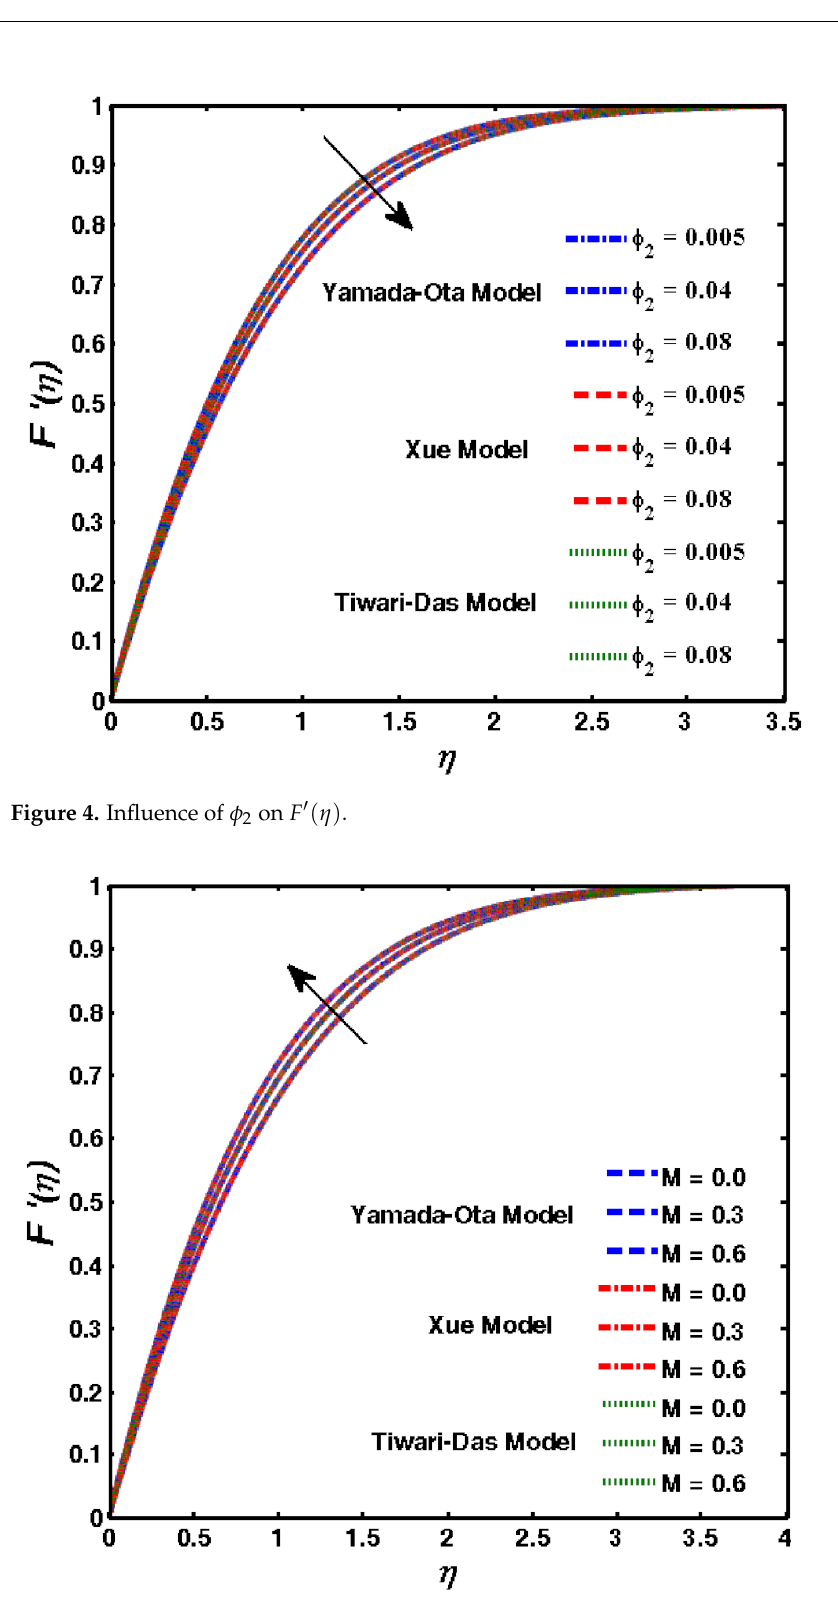
Figure 5. Influence of M on F (cid:48) ( η )